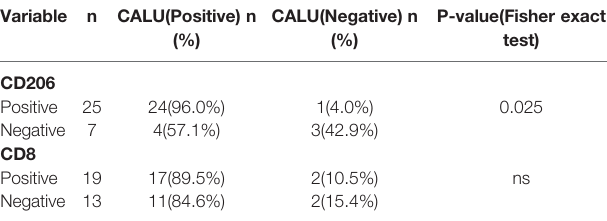
Analysisof theIHCscore ofeach patient indicated a signi fi cant correlation between CALU and CD206 co-expression in stromal components, suggesting the association of CALU with macrophages. ns, not signi fi